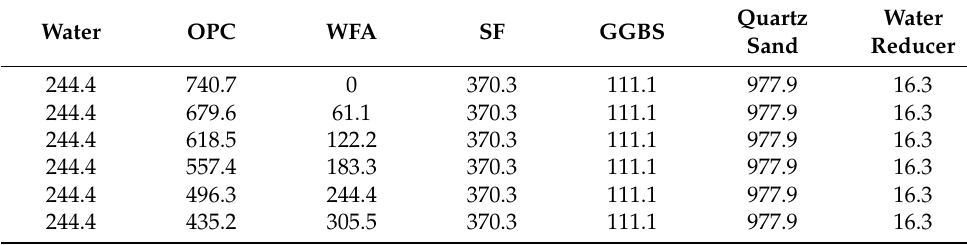
Table 1. Mixture design of WFA-RPC per one cubic meter